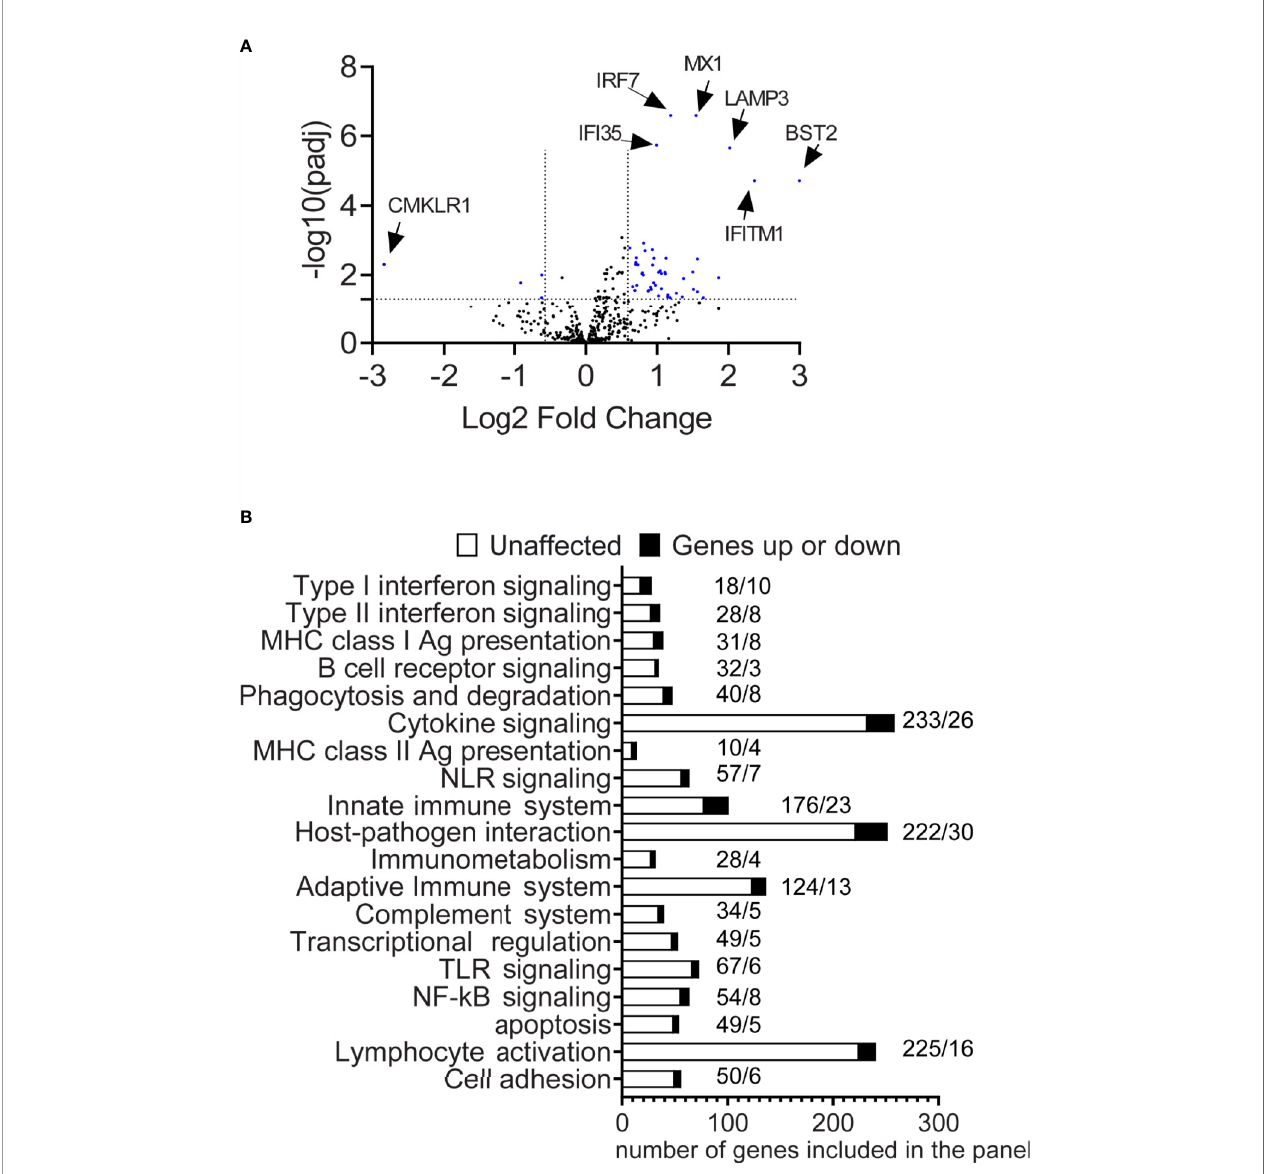
FIGURE 1 | Differential expression of immune genes in the conjunctiva of SS patients. (A) A volcano plot shows − log10(p-value) and Log 2-fold change in gene expression in SS-KCS patients compared to control subjects (fold increase >1.5 or fold decrease <1.5 and p adjusted value of 0.05). P-value thresholds were adjusted using the Benjamini – Hochberg method of estimating false discovery rates. The horizontal line indicates p=0.05, and the two vertical lines indicate greater or lower than 1.5-fold. (B) Pathway descriptors are included in the panel. Dark bars indicate modulated genes (up or down), and white bars show unaffected genes. SS-KCS, Sjögren Syndrome keratoconjunctivitis sicca. Numbers above the bars indicate the number of unaffected genes (left) followed by the affected genes